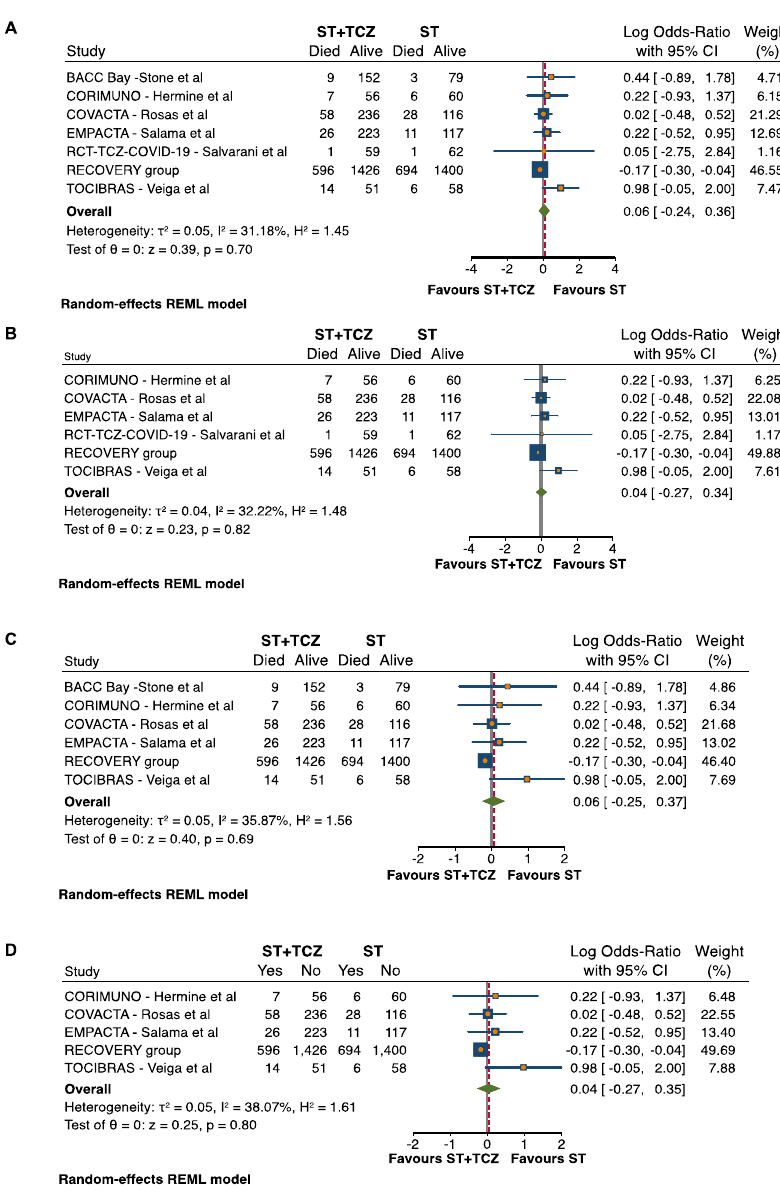
Figure 3. Forest plot in ( A ) all RCTs, after exclusion of RCTs ( B ) with weak allocation concealment, ( C ) with weak blinding, and ( D ) with both weak allocation concealment and blinding.